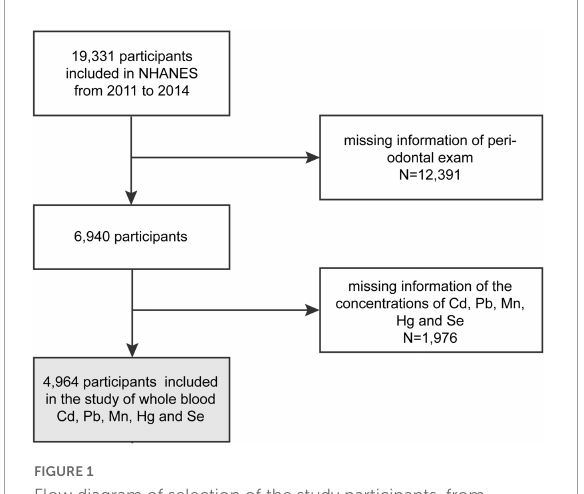
FIGURE1 Flow diagram of selection of the study participants, from NHANE 2011–2012 and 2013–2014.